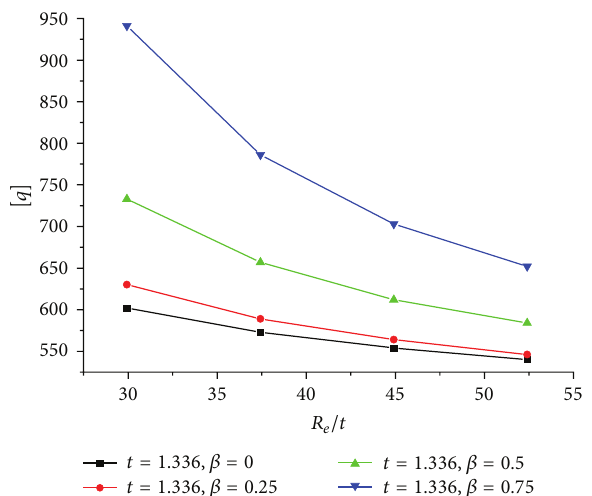
Figure 11: [𝑞] - 𝑅 𝑒 /𝑡 relation of the CFRP sheet confined GFRP pipe when 𝛽 are constants and 𝑡 is 1.336 mm.